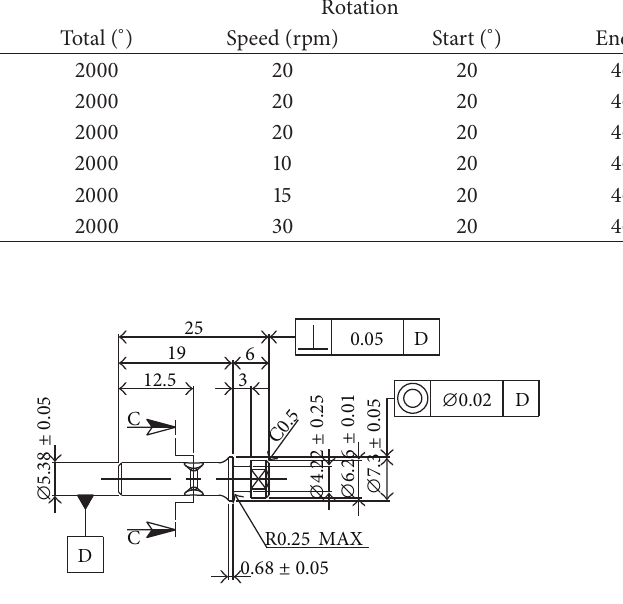
Figure 11: Dimensions of the original end plug for welding.